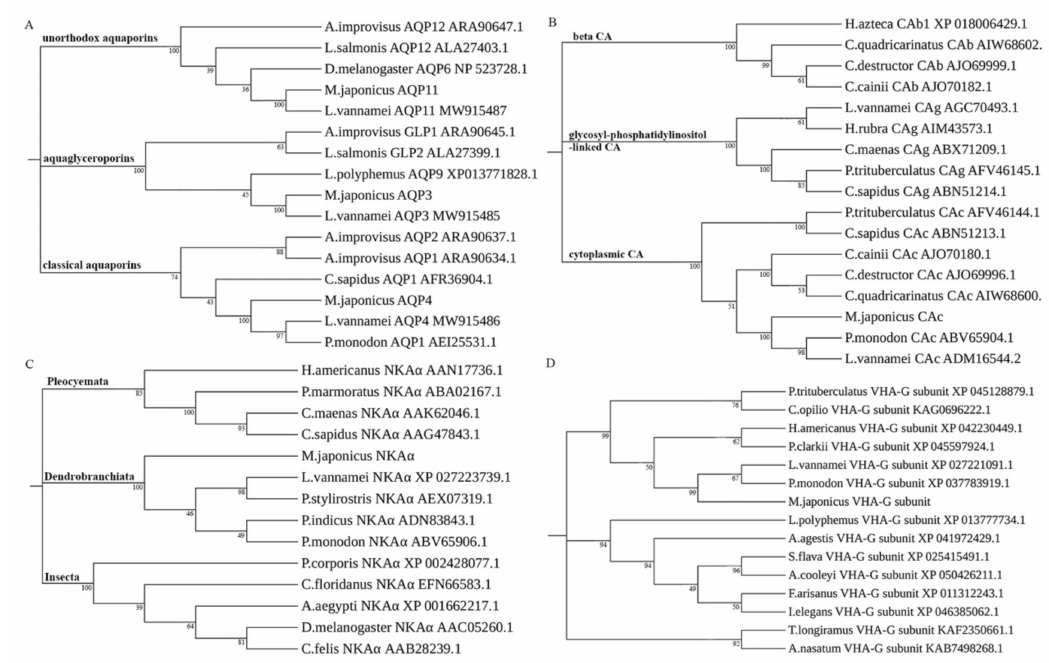
Figure 1. Phylogenetic analysis of ( A ) MjAQPs, ( B ) MjCAc, ( C ) MjNKA α , and ( D ) MjVHA-G based on NJ method. Phylogenetic trees based on the amino acid sequences of the AQPs, CA, NKA α , and VHA-G in various species were constructed by using MUSCLE alignment and the NJ method through MEGA X software. The node value indicates the percentage of 1000 bootstrap